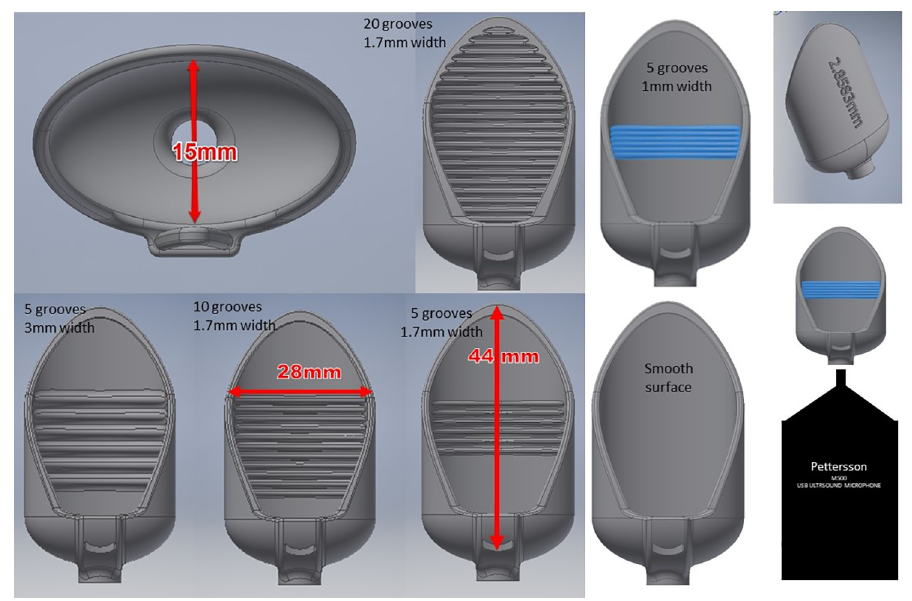
Fig 5. Examples of pinna model variations and dimensions with microphone set up.